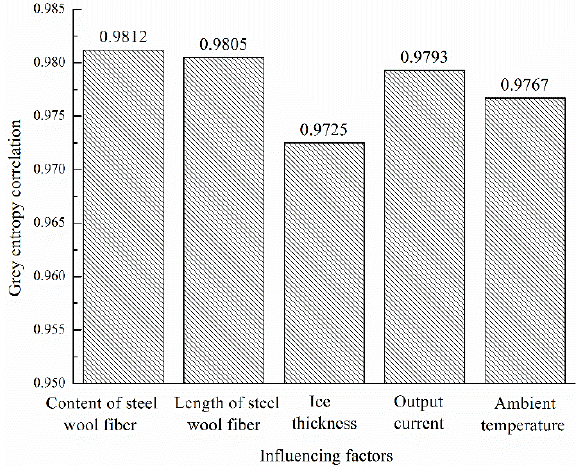
Figure 16. The grey entropy correlation of five influencing factors.